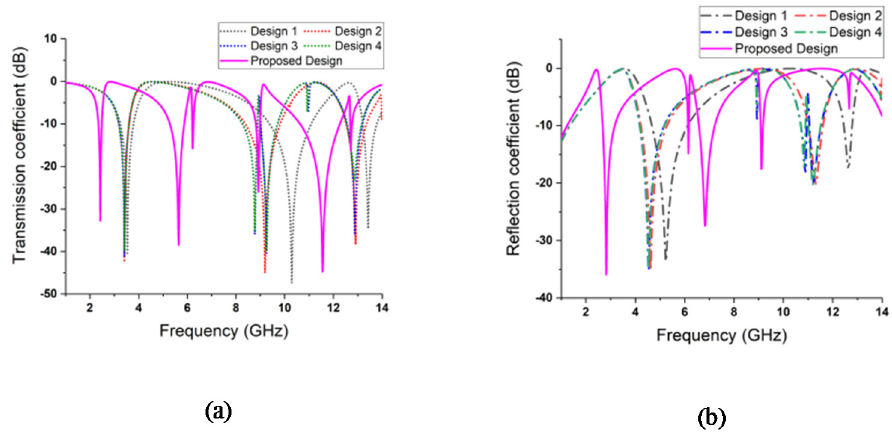
Figure 3. ( a ) Transmission coefficient (S21); ( b ) reflection coefficient (S11) based on the evaluation of metamaterial unit cell design.